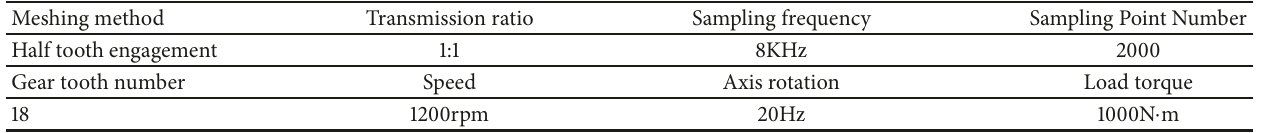
Figure 16: Gear Drive Test Bench. Table 5: Gear transmission test bench